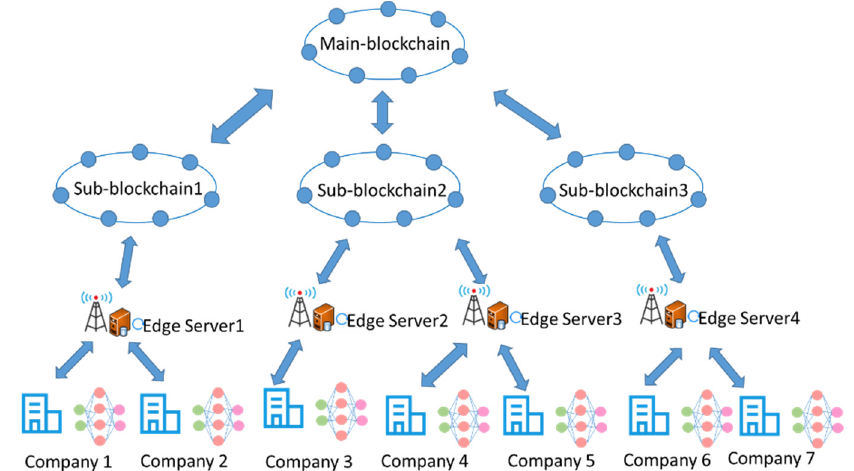
Figure 6. Schematic diagram of the asynchronous federation learning algorithm.